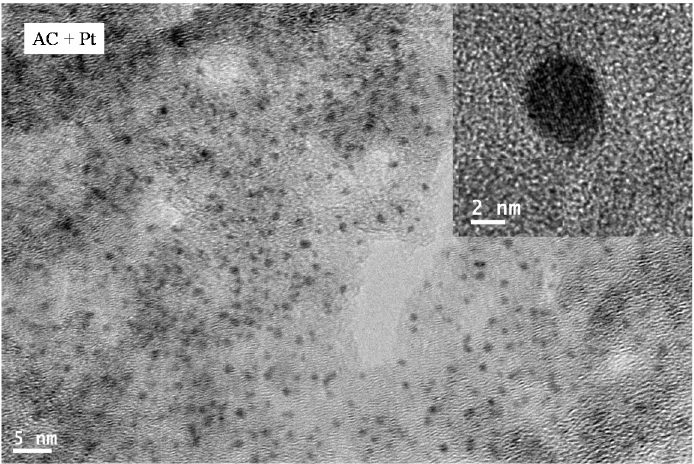
Figure 3. HRTEM images of Pt-anchored activated